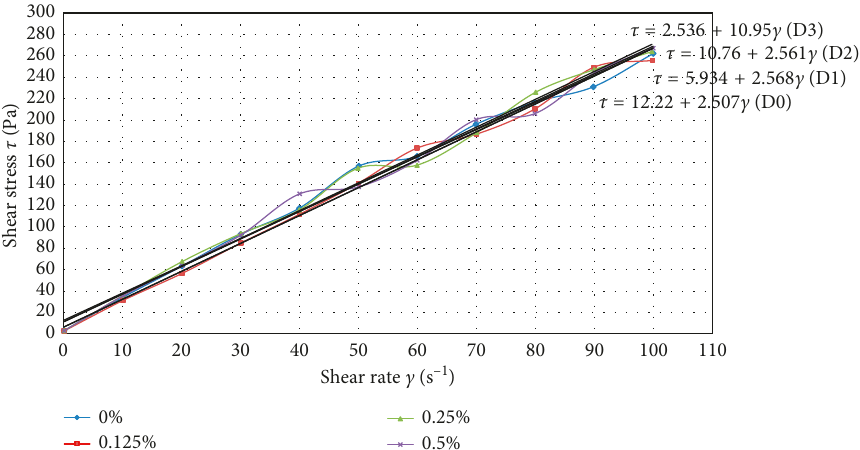
Figure 7: Flow curves of nanomodified cement pastes after 120min of mixing.